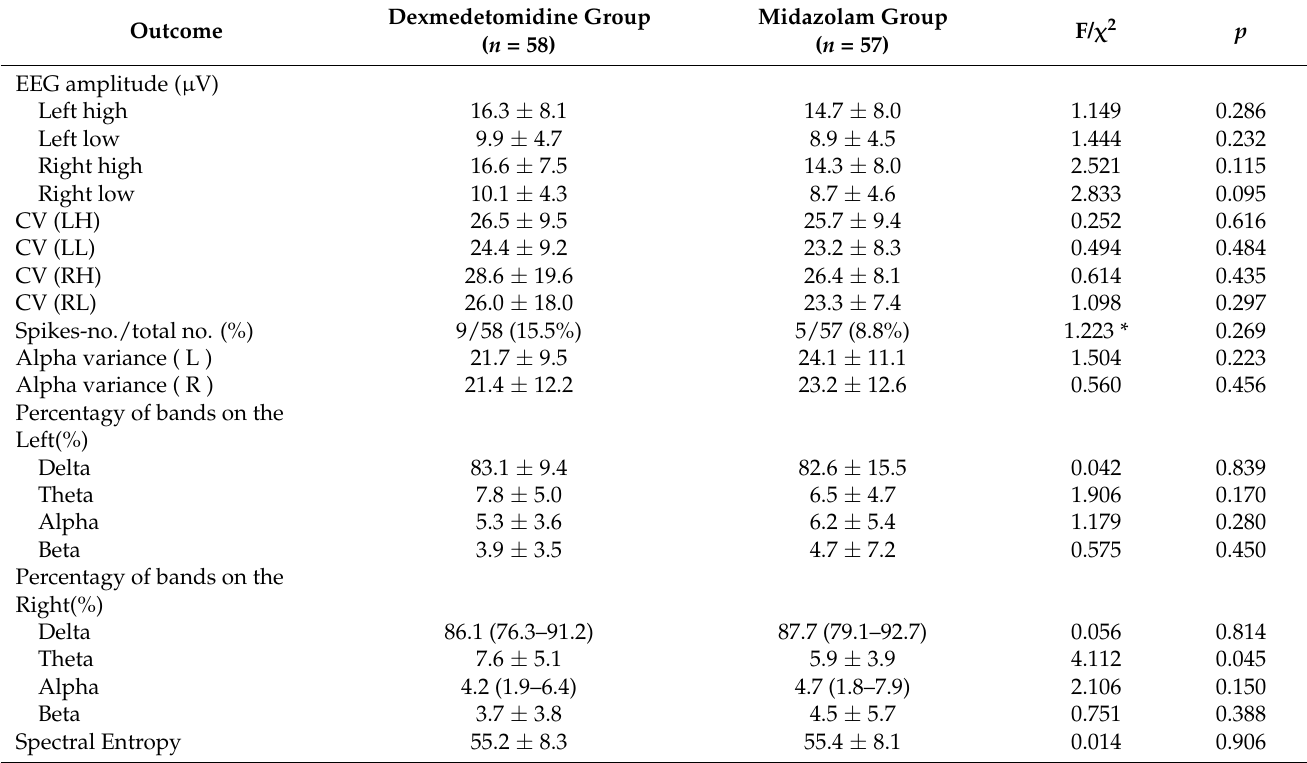
Table 3. qEEG on day